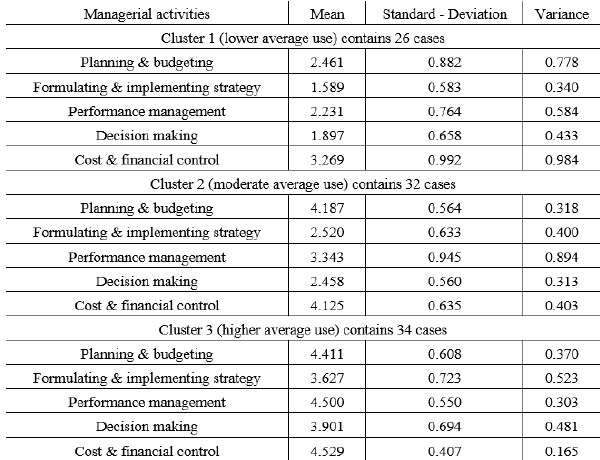
Table 1: The use of management accounting system information for the performance of the indicated activities – manager clusters in Poland